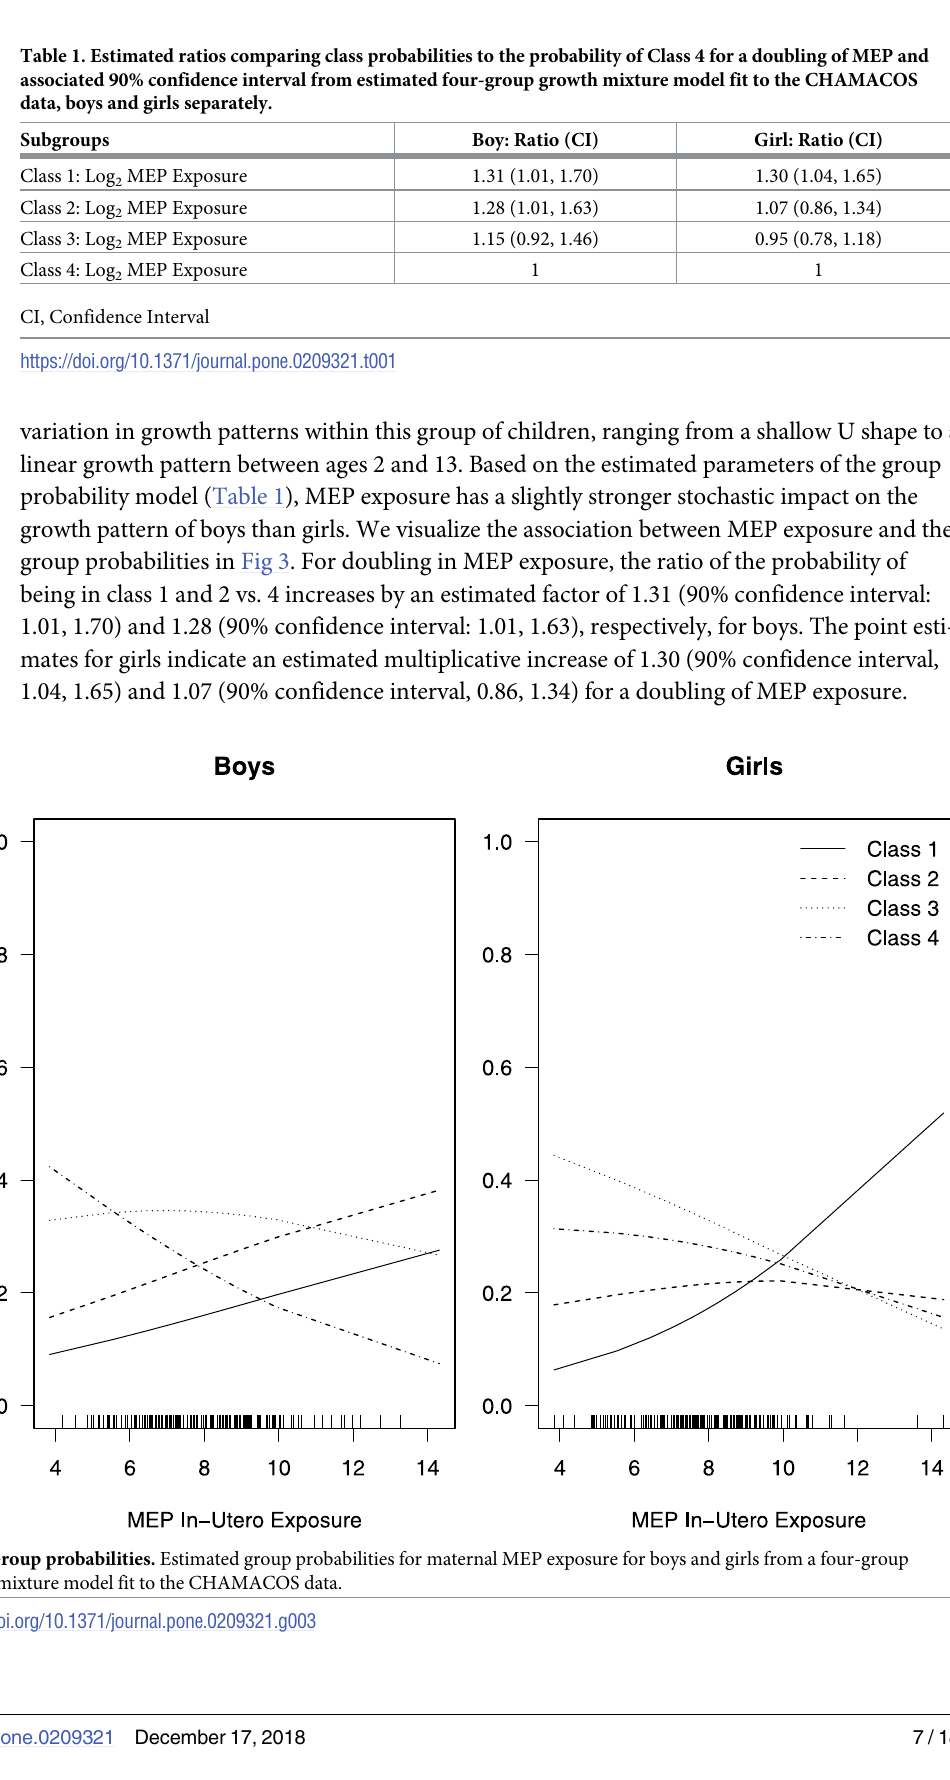
PLOS ONE | https://doi.org/10.1371/journal.pone.0209321 December17,